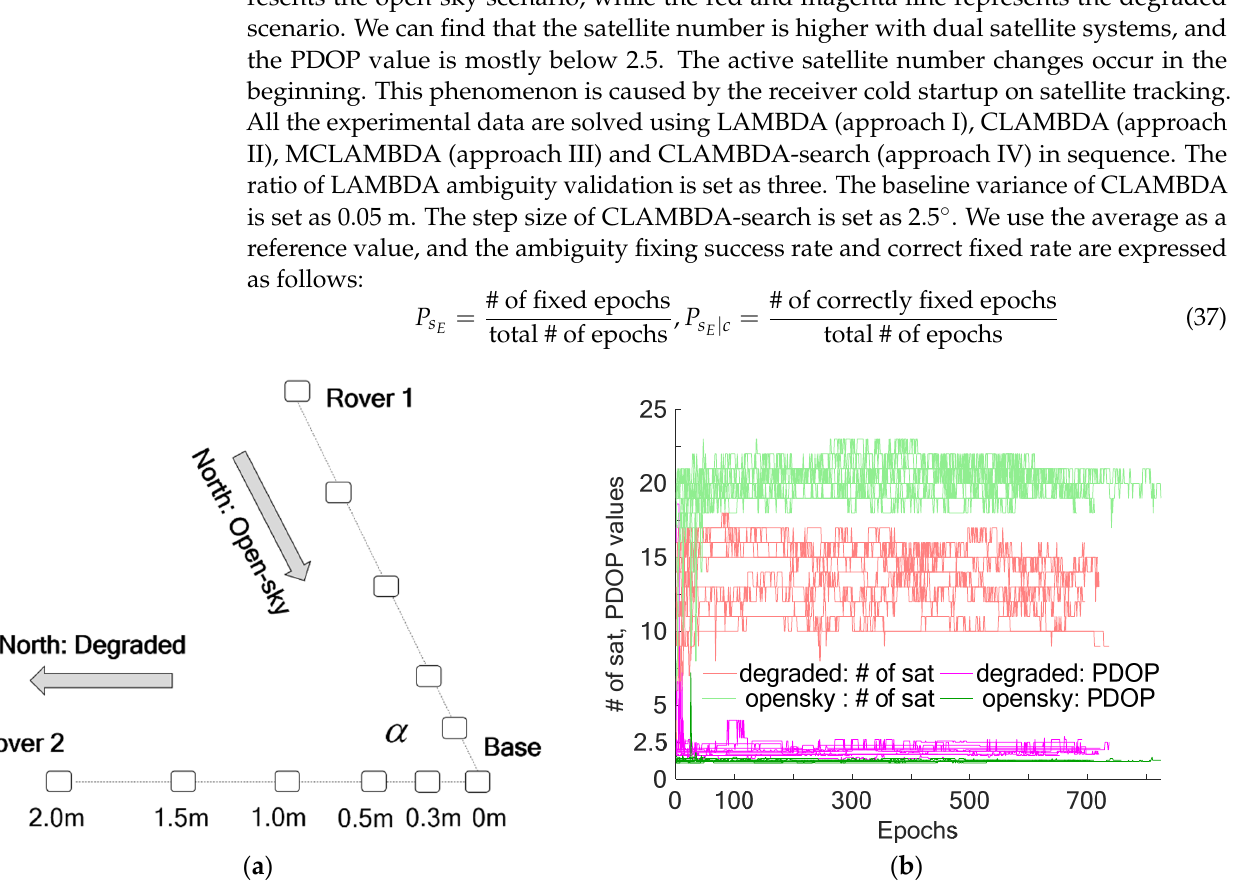
Figure 4. ( a ) Multi-receiver setup. ( b ) Number of observed satellites and PDOP values with cutoff satellite elevation of 10 ◦ º .